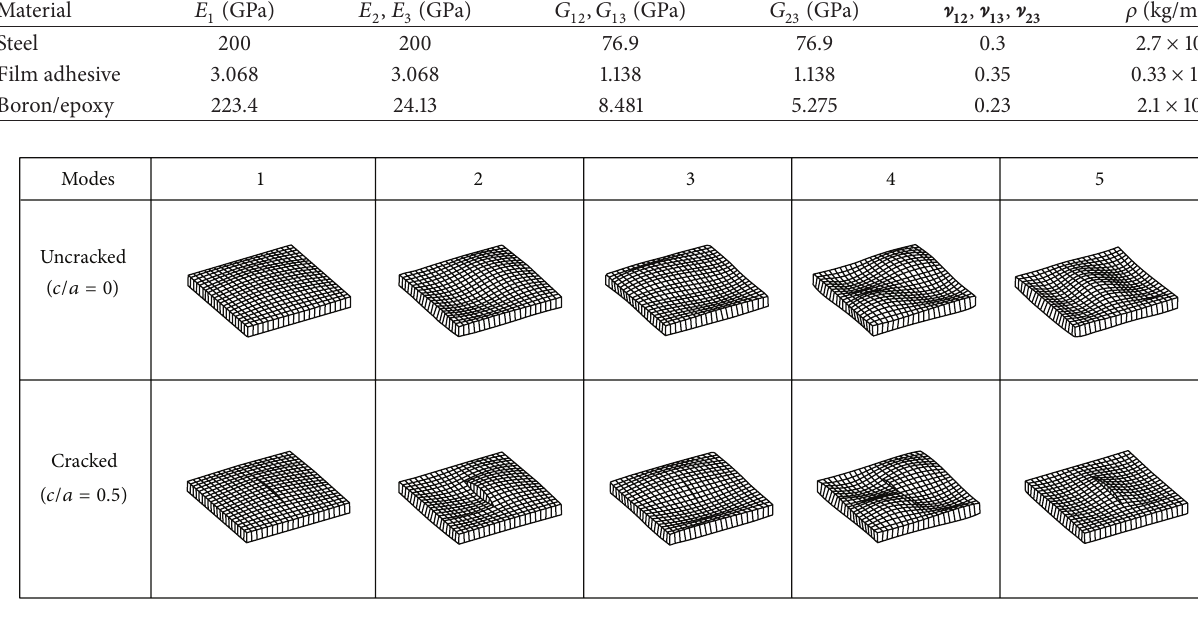
Figure 3: Mode shapes of uncracked and cracked plates.